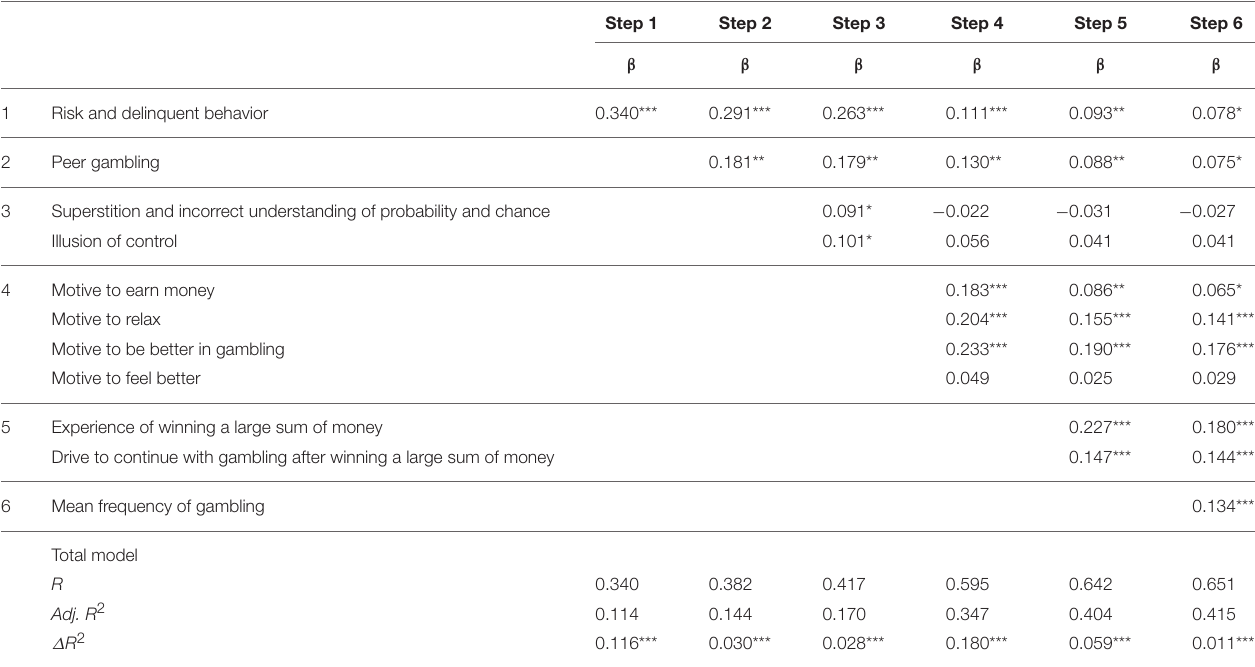
TABLE 5 | Results of hierarchical regression